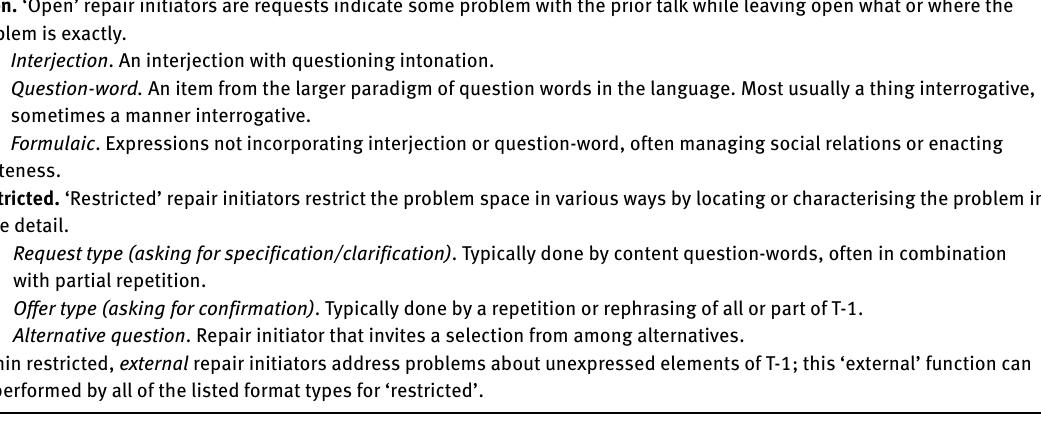
Table 2: Some basic format types for other-initiation of repair